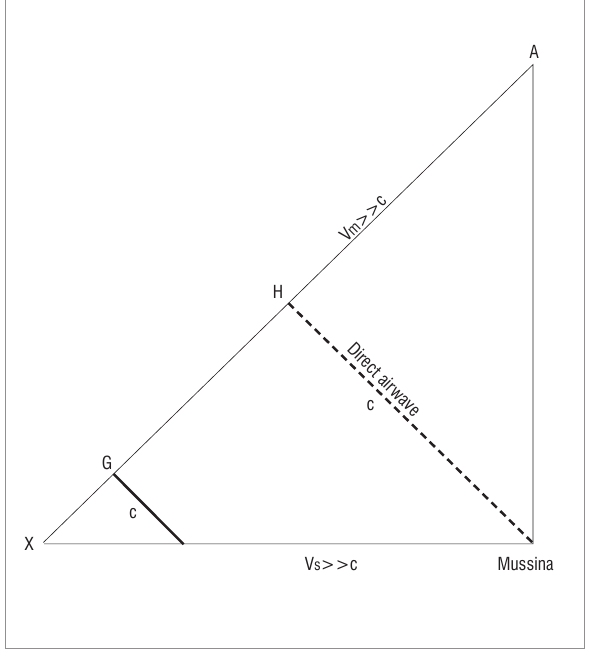
Figure 6: Schematic diagram showing one of the possible trajectories of the meteor in profile, specifically that along line A-X in Figure